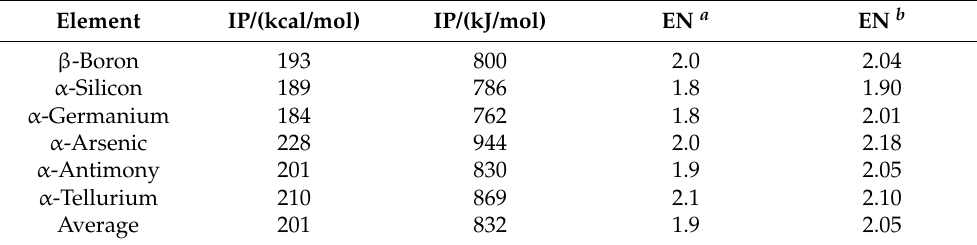
Table 1. The six elements commonly recognized as metalloids (Reprinted with permission from ref. [17]. Copyright 2013, American Chemical Society).